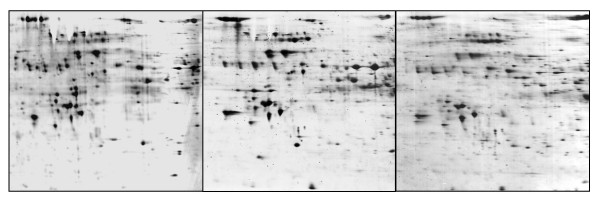
Reproducibility of xylem sap 2-DE patterns. 2-DE patterns of xylem sap proteins from three independent sets of flowering, 12-week-old Brassica napus plants that were grown independently during a period of eight month. The left hand image shows the protein gel represented in Figure 2.